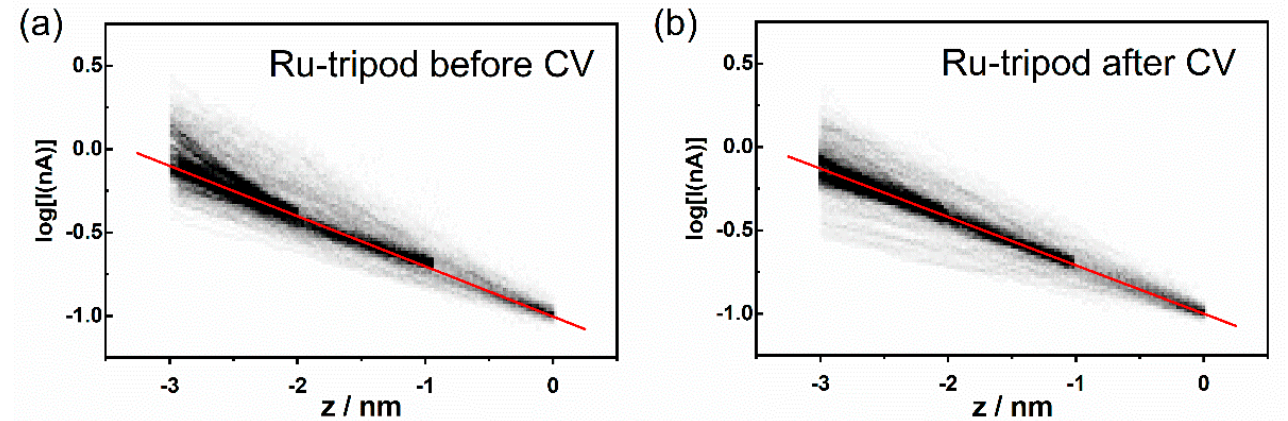
Figure 8. 2D semilogarithmic histogram of tunneling current–distance (I–z) curves for the Os-tripod SAM on Au(111): ( a ) before; ( b ) after cyclic voltammetry experiment. Three sets of I–z curves were measured starting at setpoint currents of 0.1 nA, 0.2 nA and 0.4 nA. Approach rate was 1 nm s − 1 , bin size log(I) = 0.02, z = 0.02 nm. Red line represents the best least square fit of the most probable log(I) values as a function of z.